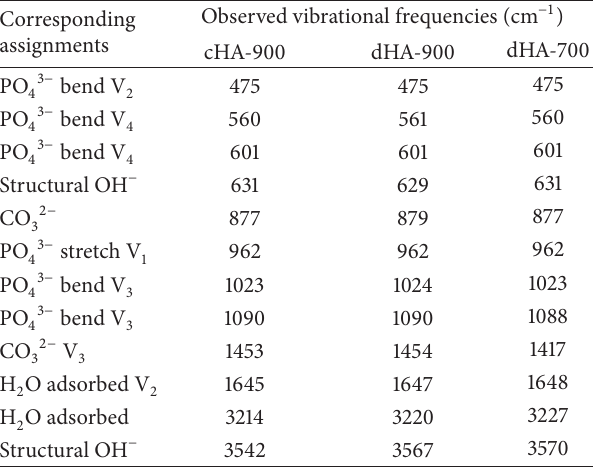
Table 2: FTIR spectra of cHA-900, dHA-900, and